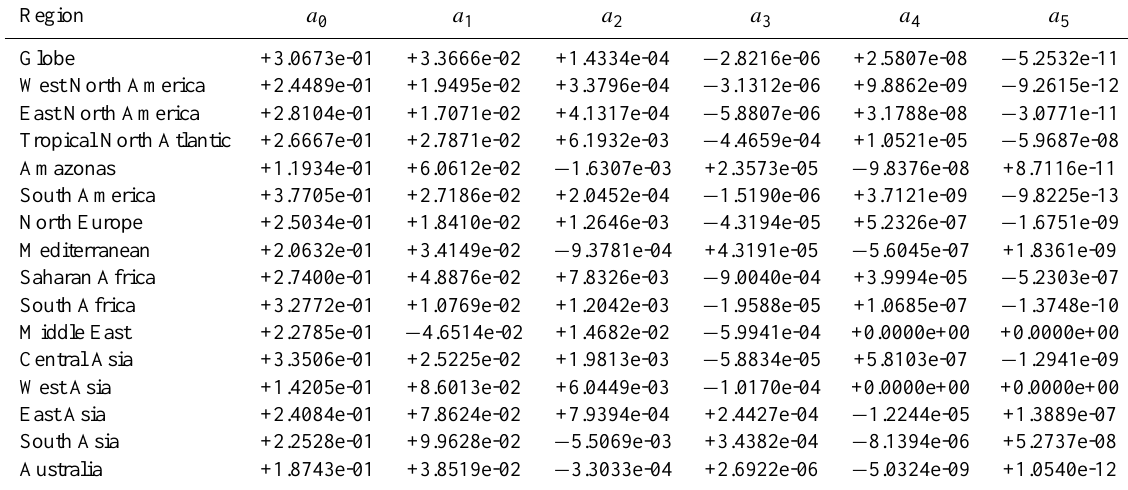
Table A2. Best fit (least-square error) coefficients of Eq. (1) for the relative standard deviation of the error in each geographical region. Region